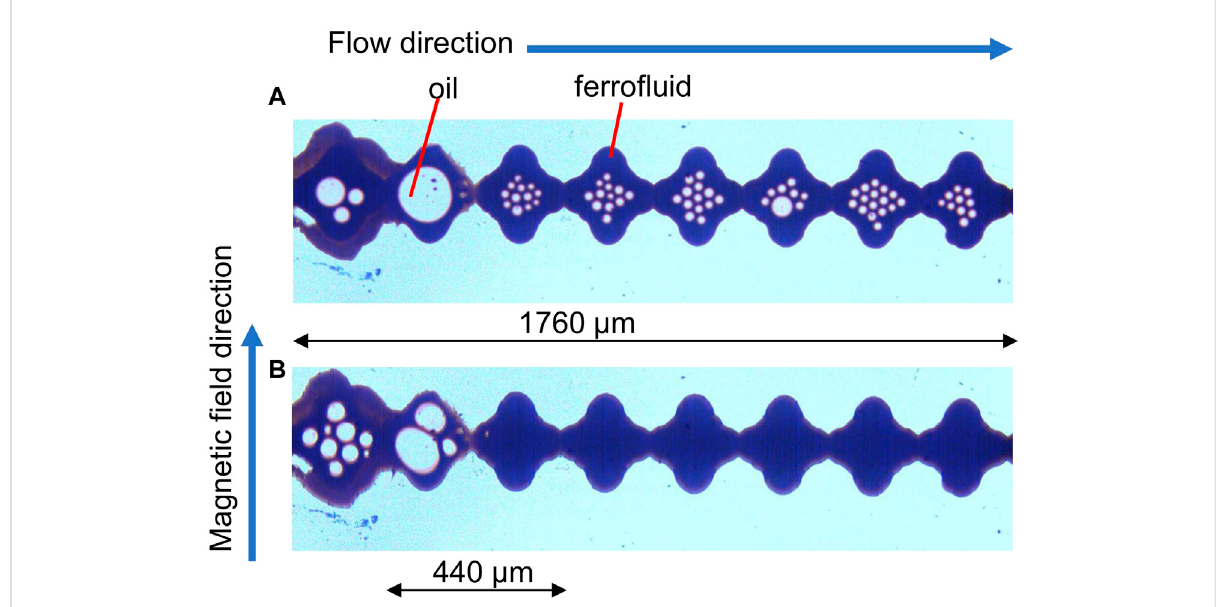
FIGURE 16 Displacement of small oil blobs in a converging/diverging single channel with fi rst ferro fl uid only, then ferro fl uid and magnetic fi eld: (A) The micromodel was fi rst fl ooded without magnetic fi eld for 40 h, and then (B) the fl ooding continued with a static magnetic fi eld for another 26 h and 100% of the small oil blobs in the right six pores were displaced. This is a portion of the entire micromodel and upstream and downstream are not shown (based on Wang et al.,